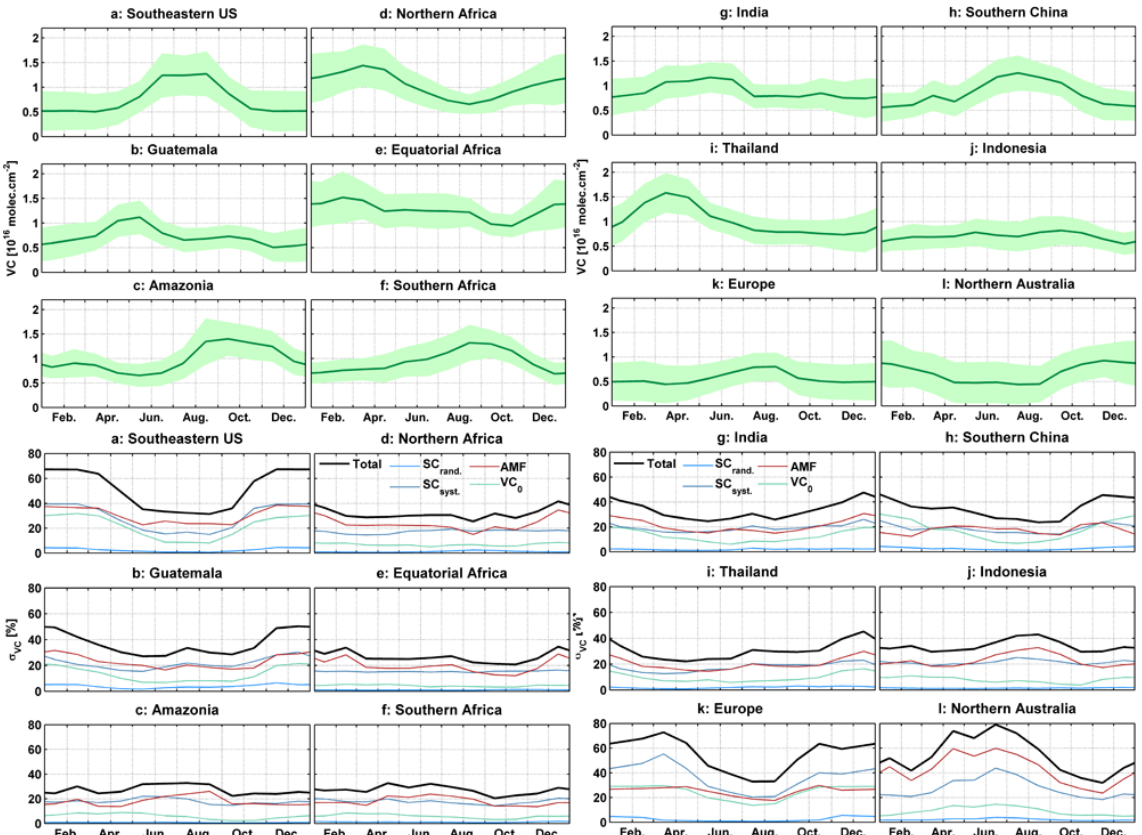
Fig. 10. GOME-2 H 2 CO vertical columns averaged regionally between 2007 and 2011 (upper panels), and their estimated relative errors (lower panels) with the contributions of each error source. The limits of the regions are shown in Fig.